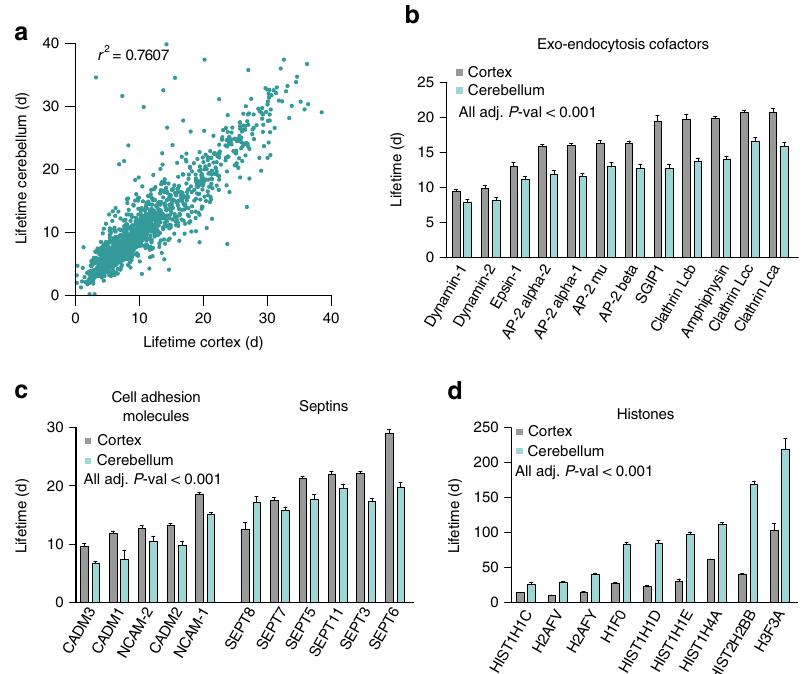
Fig. 5 The lifetimes from speci fi c pathways are different between brain cortex and cerebellum. a Scatter plot of protein lifetimes in the cortex homogenate vs. the cerebellum homogenate. b – d Proteins signi fi cantly different in the two tissues for several pathways identi fi ed by the classi fi cation of lifetime changes (Bonferroni adjusted P -value < 0.001; see also Supplementary Fig. 20). Several exo-endocytosis cofactors are shorter-lived in the cerebellum when compared to the cortex ( b ), as well as speci fi c adhesion molecules of the brain ( c , left side). With the exception of septin 8, most septins (3, 5, 6, 7, and 11) are also longer-lived in the cortex ( c , right side). On the contrary, histones are more stabilized in the cerebellum than in the cortex ( d